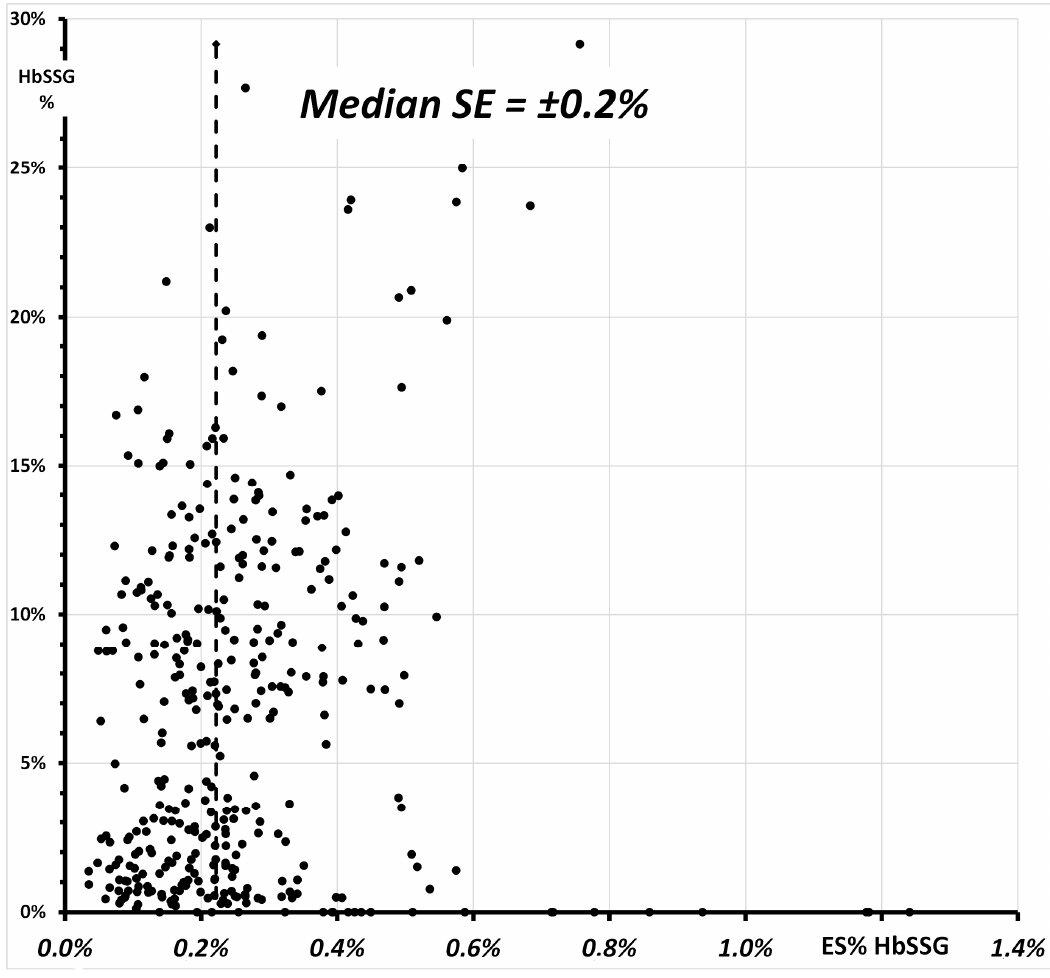
Figure 8. Relationship of the SE% of the 368 measurements of glutationyl hemoglobin (Figure 7) and of the respective value of HbSSG%. The vertical line highlights the median value of the SE in the measured